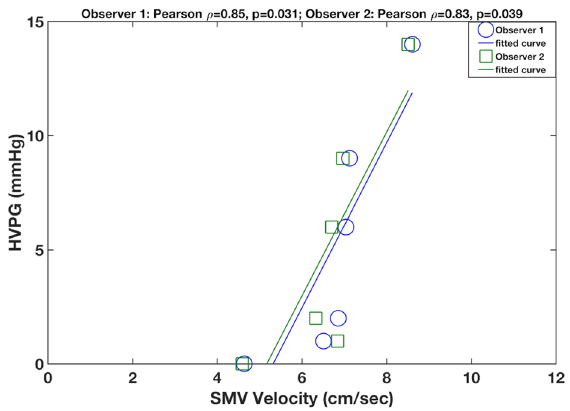
Figure 3. Correlation plots between average velocity in the superior mesenteric vein (SMV) measured with the k−t accelerated acquisition and HVPG measurements in 6 patients with transjugular biopsy. SMV velocity measured by observer 1 (Pearson’s r = 0.85, p = 0.031) and observer 2 (Pearson r = 0.83, p = 0.039) were strongly correlated to